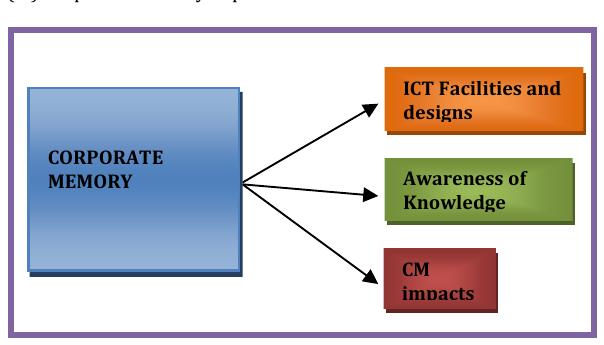
Figure 1: Research framework